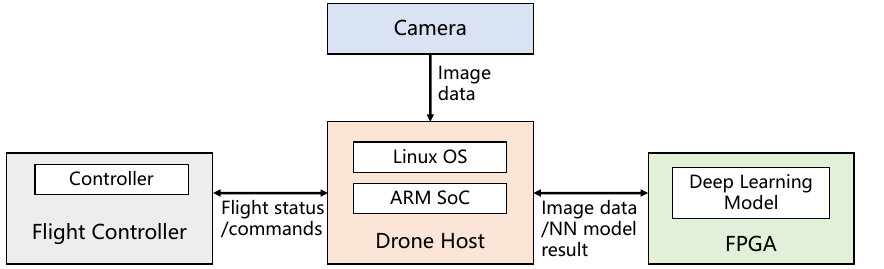
Figure 3. The architecture of the proposed intelligent system.